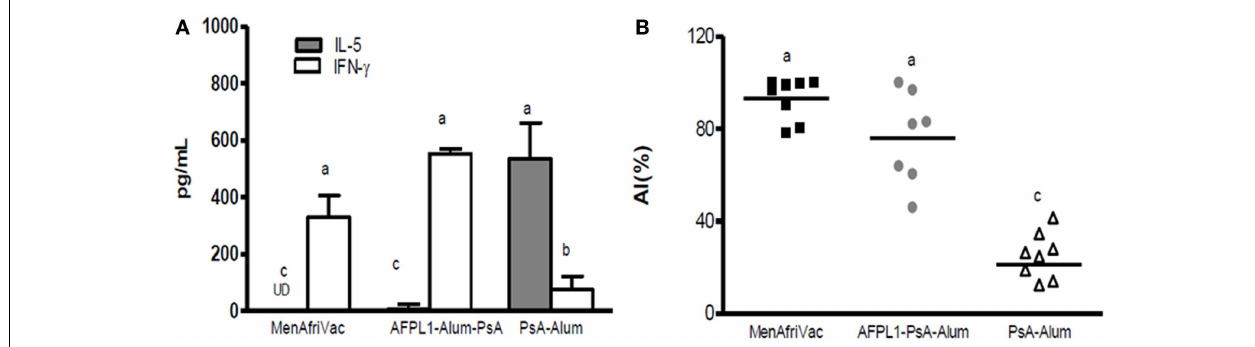
FIGURE 7 |Th1 cytokine profile and antibody affinity maturation after a plain PsA booster . Groups of mice received 5 µ g PsA adsorbed onto Alum or together with 5 µ g of AFPL1 or conjugate vaccine MenAfriVac® via the subcutaneous route. Immunizations were performed twice, 21days apart. A subcutaneous booster of plain PsA was performed 105days after the last dose. Spleens from individual mice after the booster immunization were pooled within each group. (A) Cytokine levels, measured by ELISA are expressed as pg/mL ± SEM.